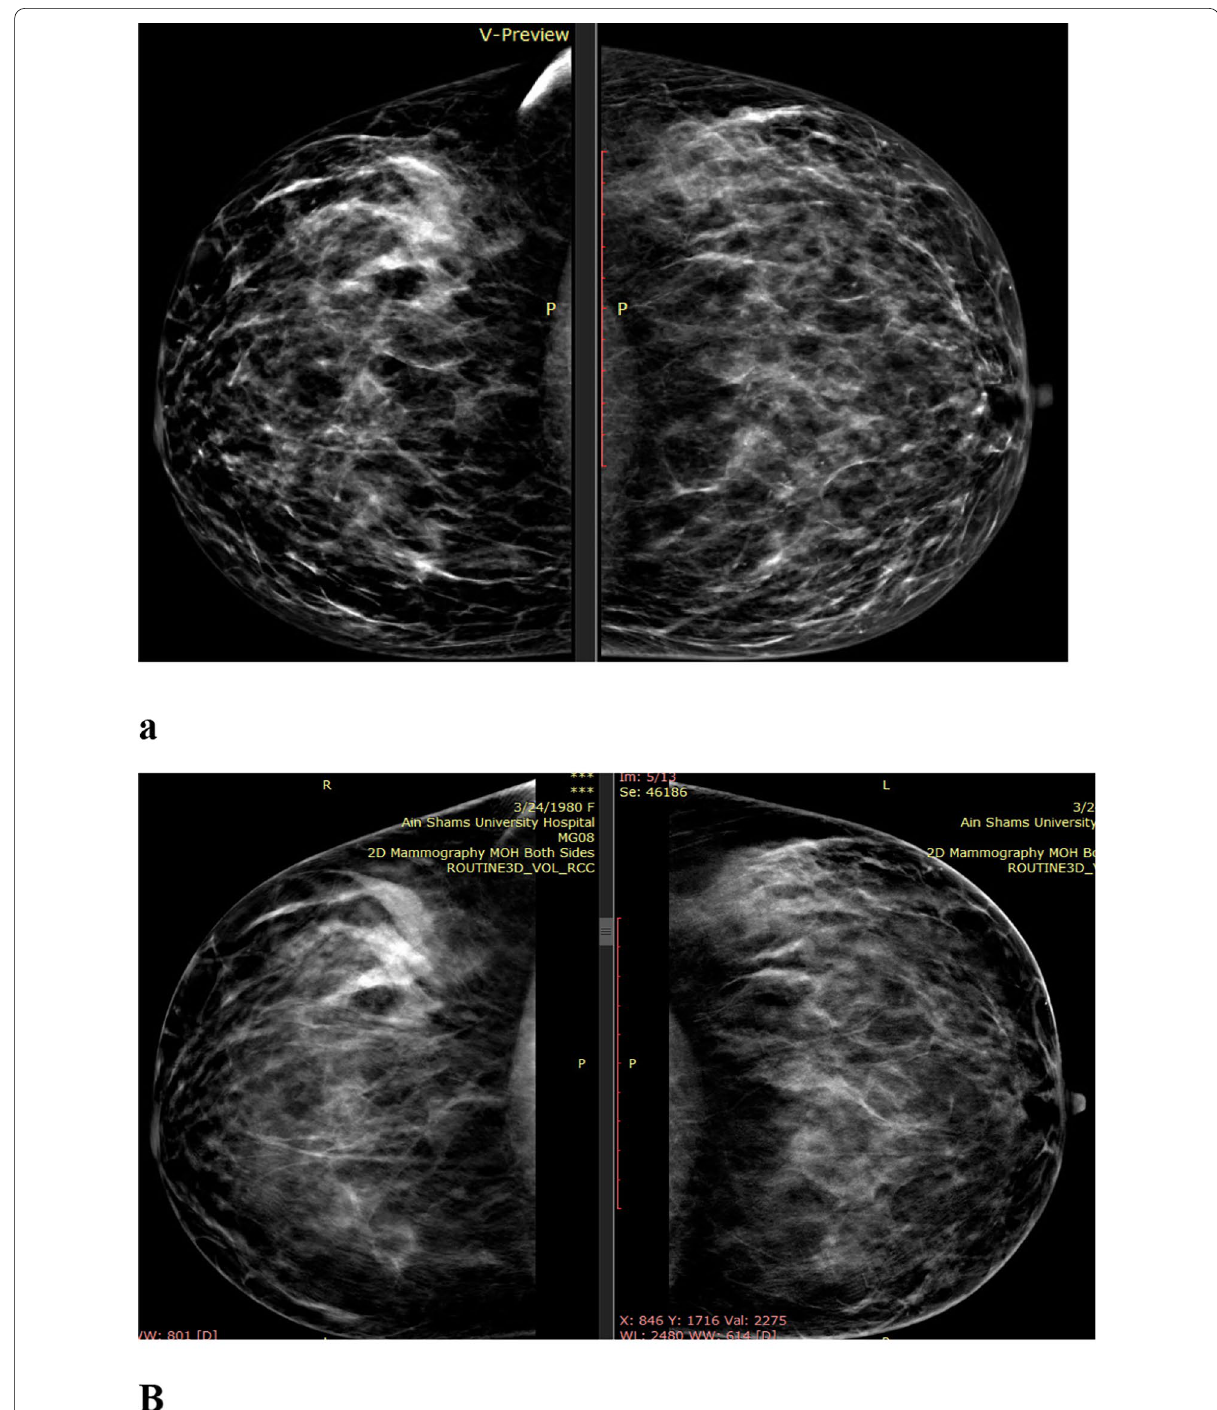
Fig. 9 A 34-year-old female came for screening. a CC view of 2DDM of both breasts shows Scattered fibro-glandular densities (ACR b). b CC view of DBT of both breasts. Right breast shows outer quadrant focal asymmetry in 2DDM which is noted in DBT as architectural distortion. BIRADS 4, proved by histopathology to be invasive lobular